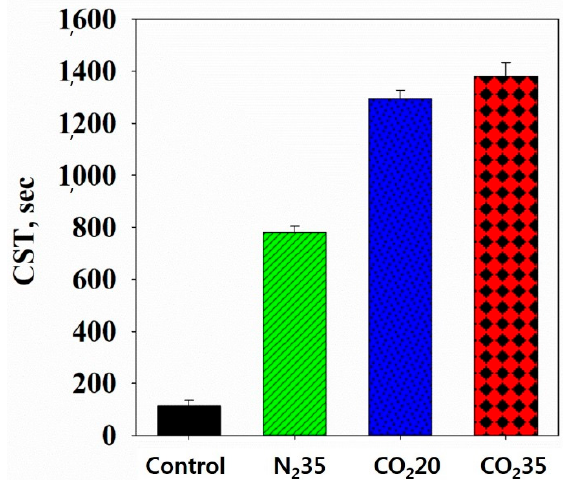
Figure 10. CST of sludge samples.